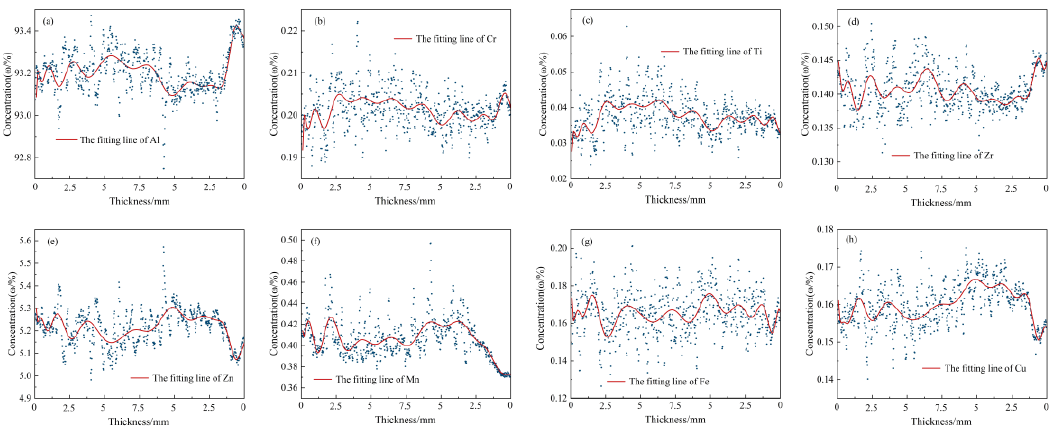
Figure 9. The average content line distribution along the thickness in the 7B05 aluminum alloy rolling plate; ( a ) Al, ( b ) Cr, ( c ) Ti, ( d ) Zr, ( e ) Zn, ( f ) Mn, ( g ) Fe, ( h ) Cu.